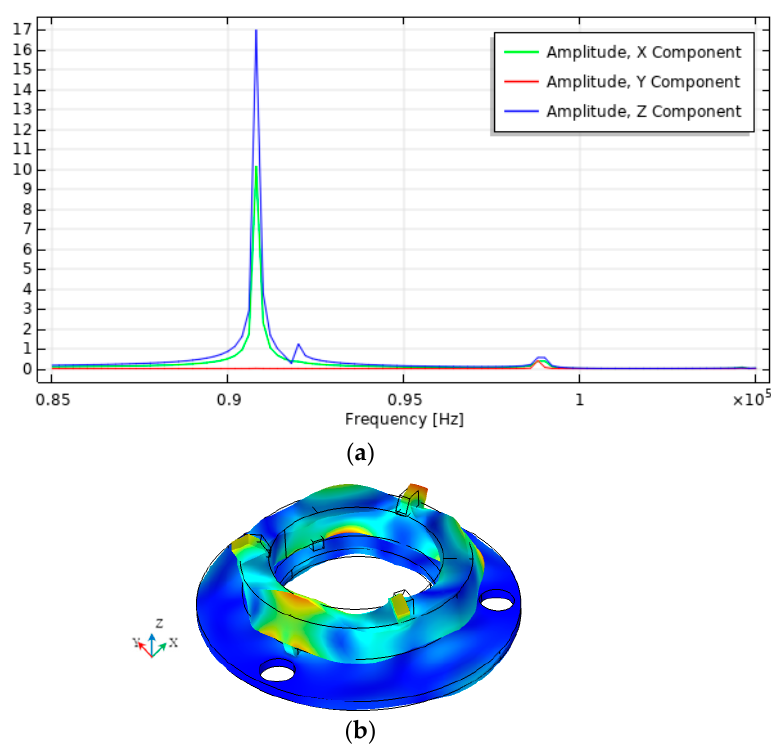
Figure 4. Results of harmonic response analysis when the top electrode is divided into three equal segments; ( a ) amplitude-frequency characteristic; ( b ) vibration modes at 90.80 kHz.